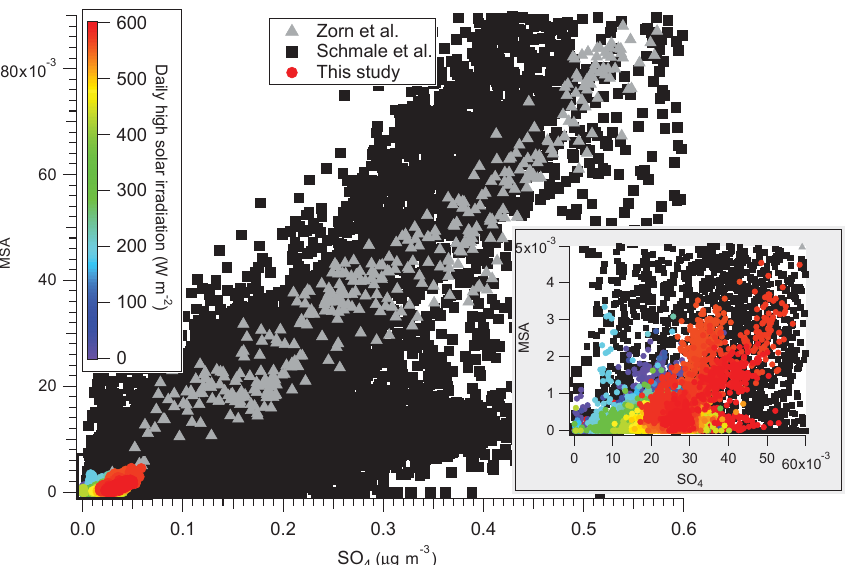
Figure 5. MSA vs. sulfate as measured by the AMS for both field seasons, colored by the daily high solar irradiance. 2ODIAC data are presented with results from Zorn et al. (2008) and Schmale et al. (2013) for context. Inset is a zoomed in area showing the 2ODIAC data in higher